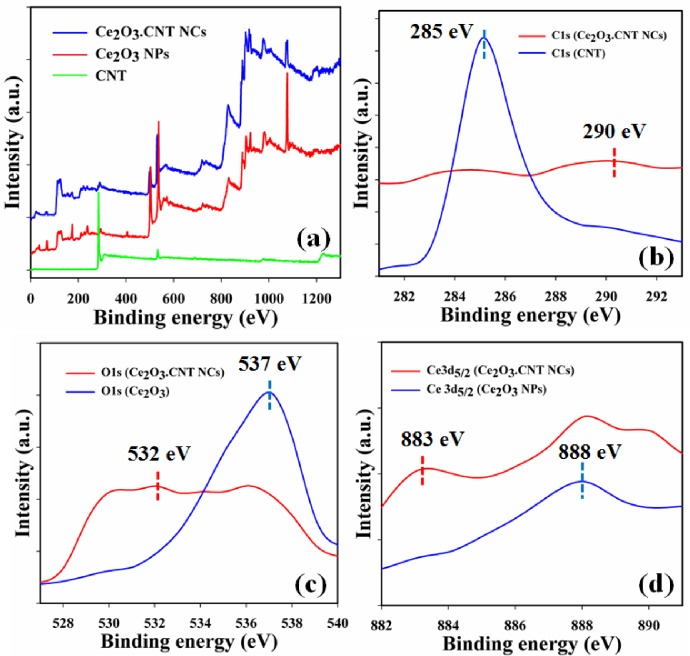
XPS spectra: (a) Ce2O3.CNT NCs, (b) C1s, (c) O1s, and (d) Ce3d5/2 level achieved with Kα1 radiation.